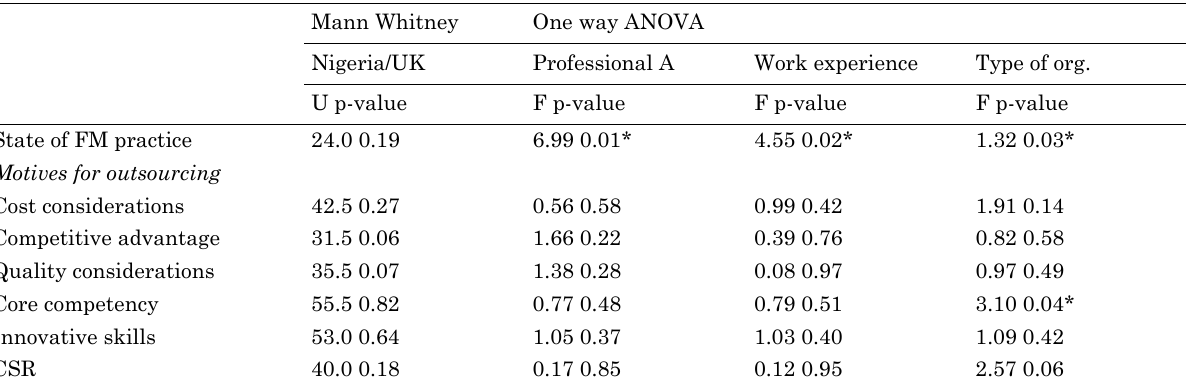
Table 4. Result of difference in response